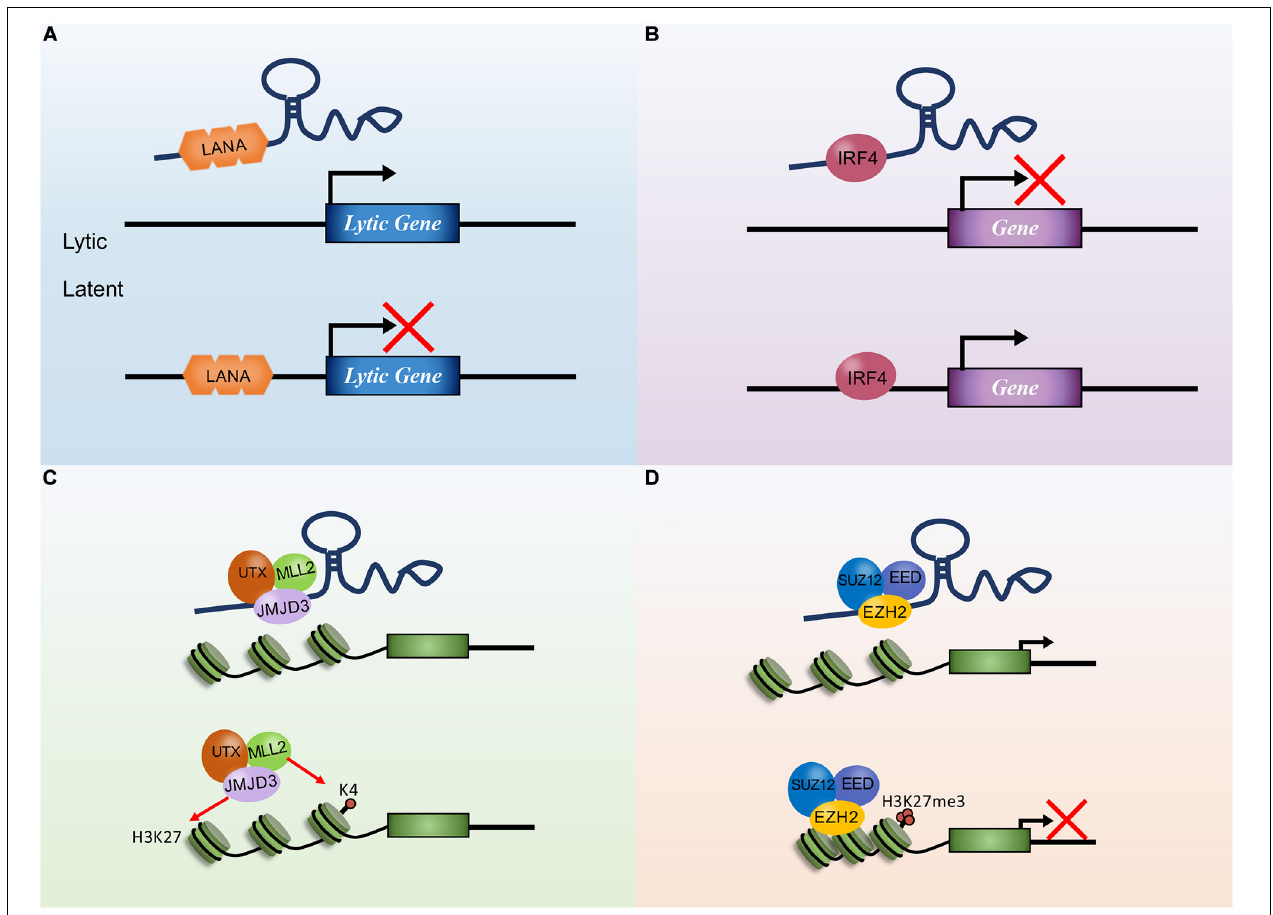
FIGURE 1 | The mechanisms of Kaposi’s sarcoma-associated herpesvirus (KSHV) polyadenylated nuclear RNA (PAN RNA) action. (A) PAN RNA directly interacts with IRF4 transcription factor and represses IRF4-driven transcription. (B) PAN RNA sequesters KSHV latency-associated nuclear antigen (LANA) protein from the KSHV genome to promote KSHV lytic replication. (C) PAN RNA binds to EZH2 and interacts with PRC2 to promote gene expression by repressing H3K27 methylation. (D) PAN RNA interaction with the histone demethylases UTX and JMJD3 to regulate gene expression by removing repressive